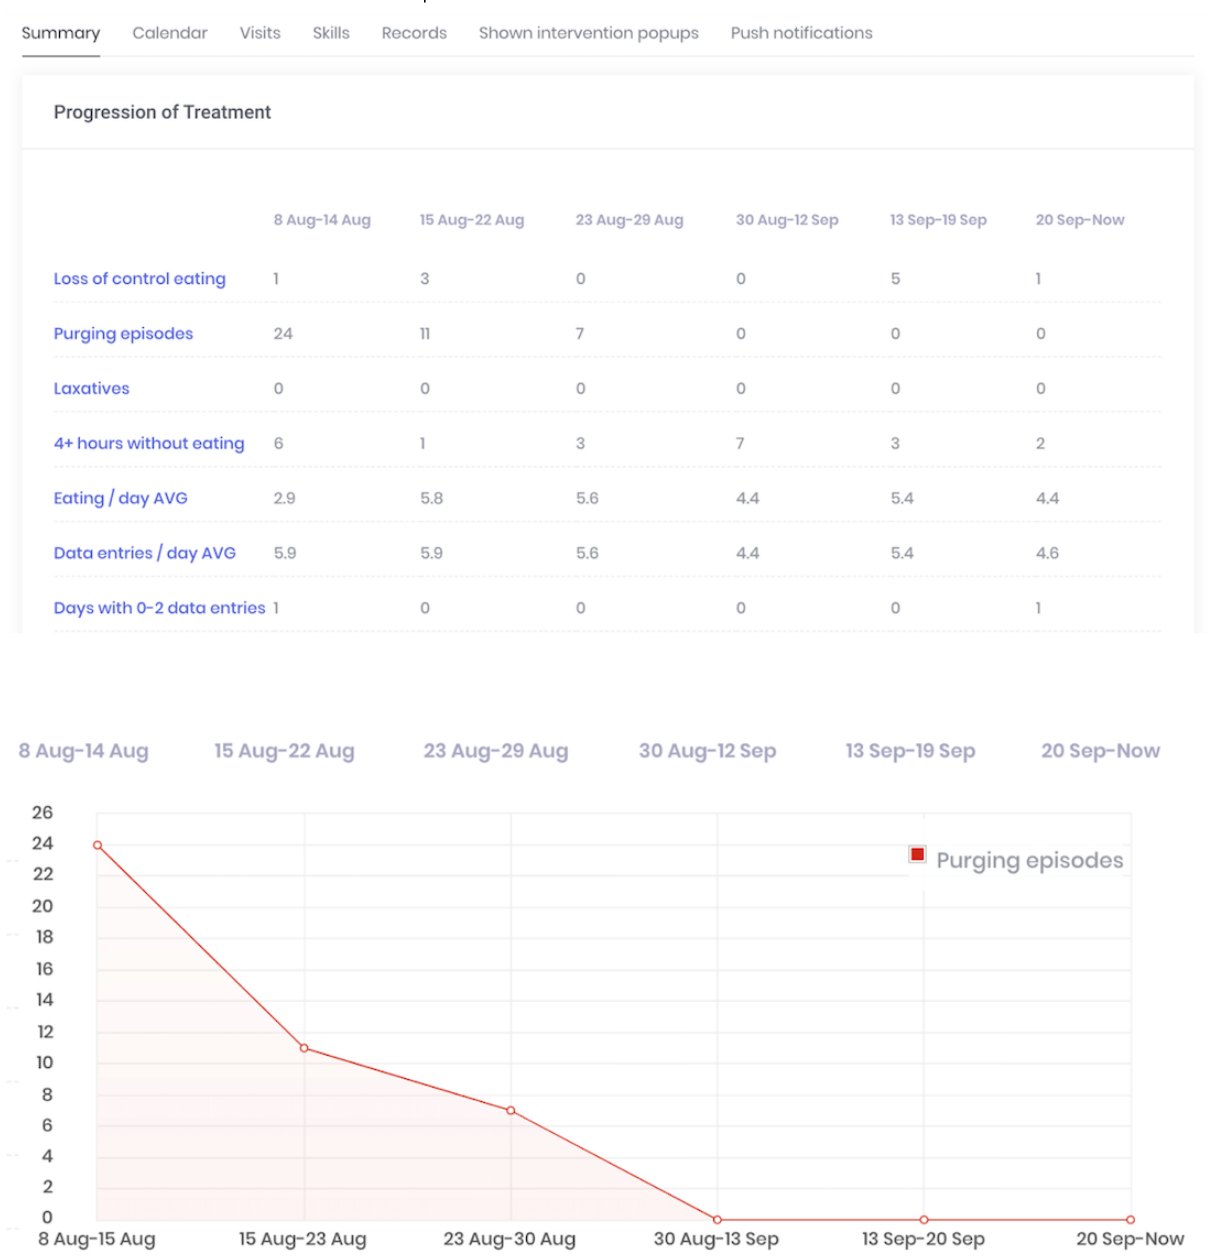
Figure 4. Patient dashboard of the CBT+